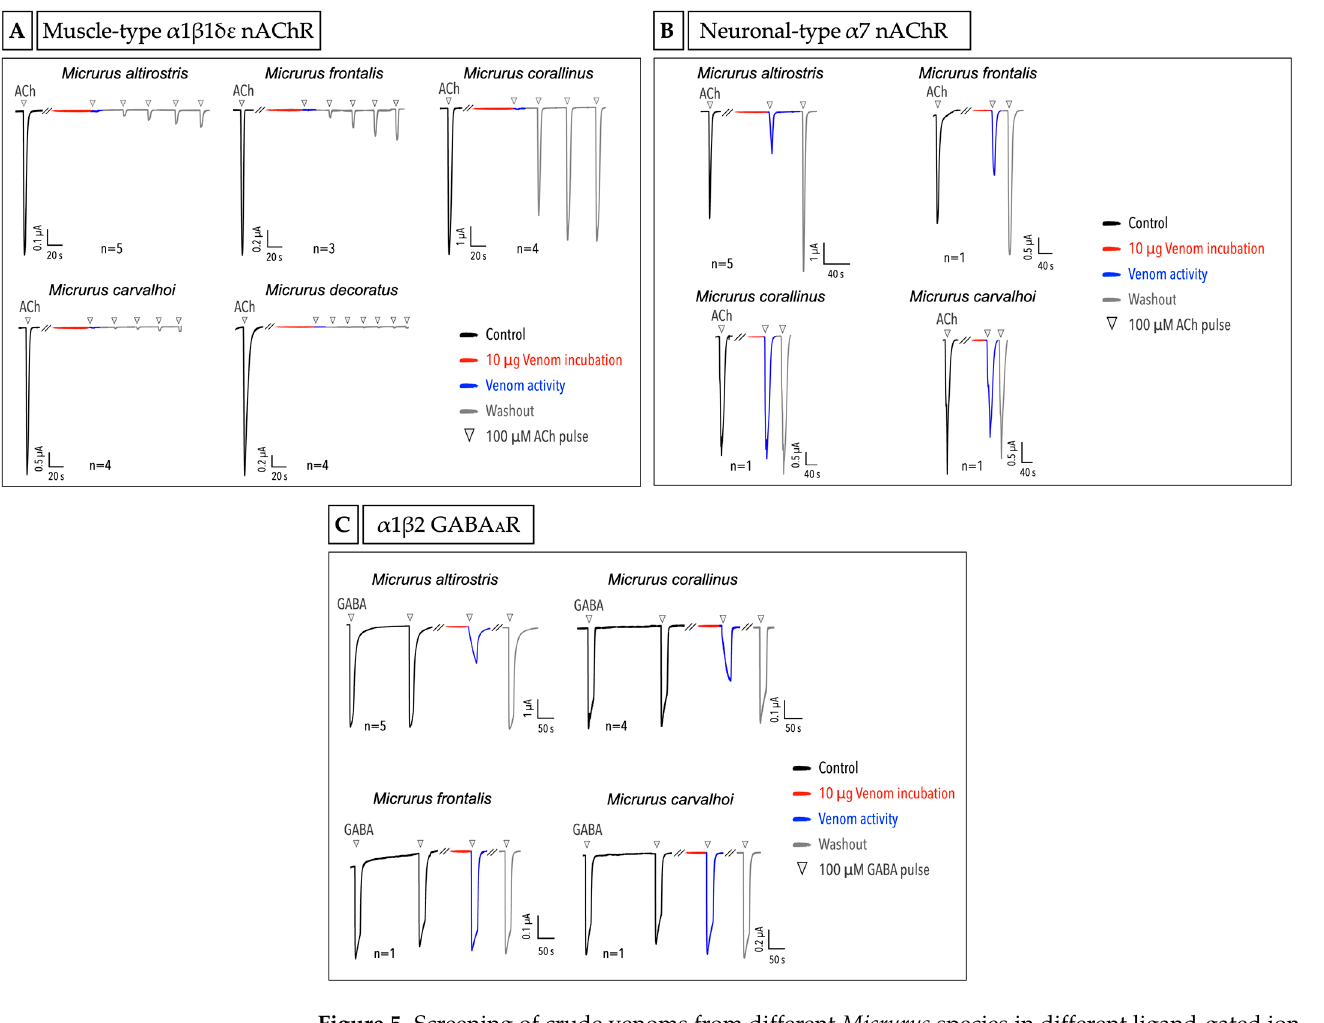
Figure 5. Screening of crude venoms from different Micrurus species in different ligand-gated ion channels. ( A ) Muscle-type α 1 β 1 δε nAChR, ( B ) Neuronal-type α 7 nAChR and ( C ) α 1 β 2 GABA A R. The black lines represent the control pulses, the red lines represent the venom incubation, the blue lines represent the receptor activity after the incubation with 10 µ g of crude venom, and the gray lines represent the agonist pulse after the cell washout. The triangles mark the point where the application of the agonist was started. The n from each experiment is shown as well as the current/time reference bar. The graphs show the trace of one experiment from a series of independent experiments, with the exception of tests with n = 1.